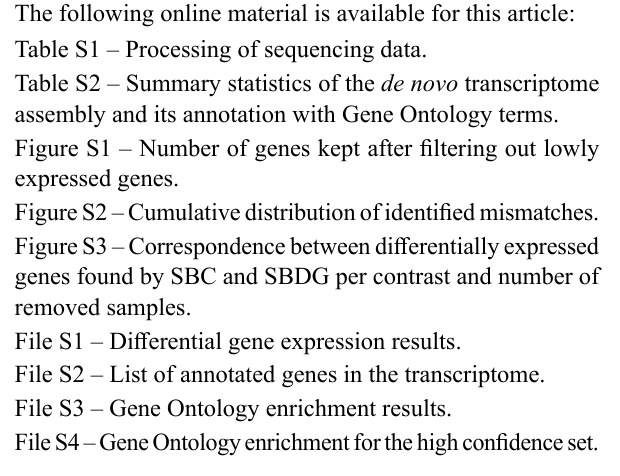
Figure S1 – Number of genes kept after filtering out lowly expressed genes. Figure S2 – Cumulative distribution of identified mismatches. Figure S3 – Correspondence between differentially expressed removed